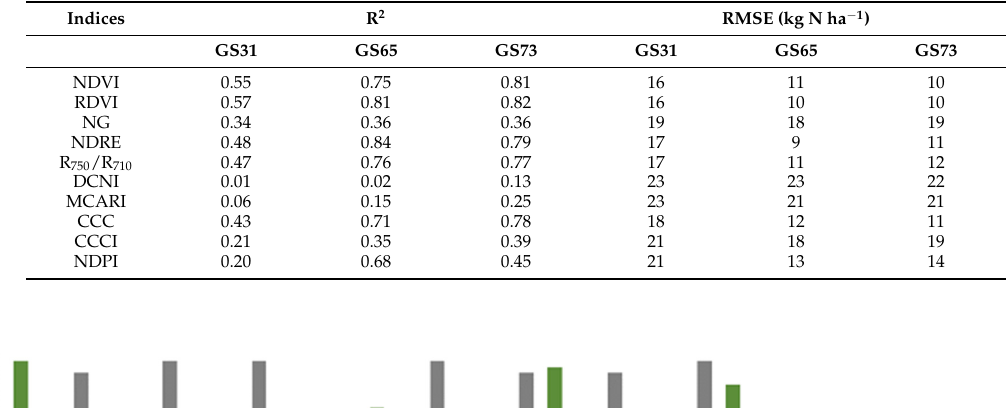
Table 4. Coefficient of determination (R 2 ) and root mean square error (RMSE) between vegetation